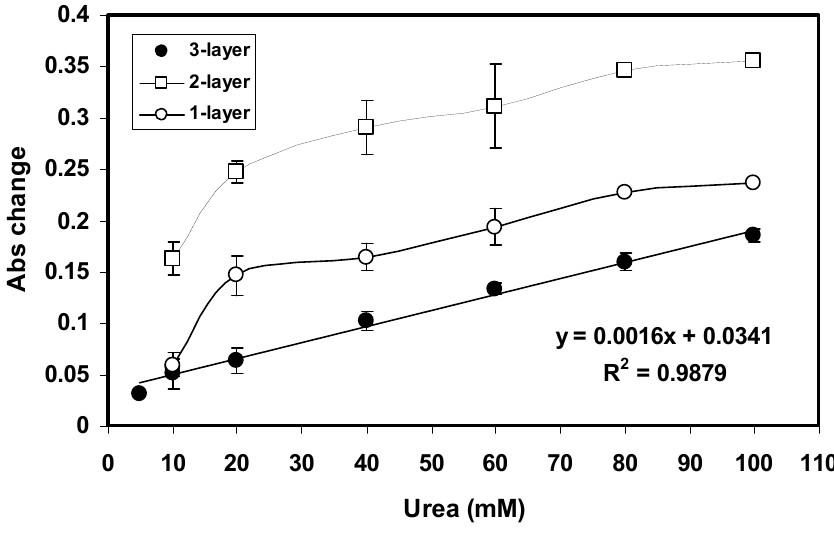
Figure 3. The relationship between ∆ A vs. [urea] at 550 nm for biosensors with different number of layers of urease enzyme in sol-gel (pH 7.5, 10 mM of Tris-HCl